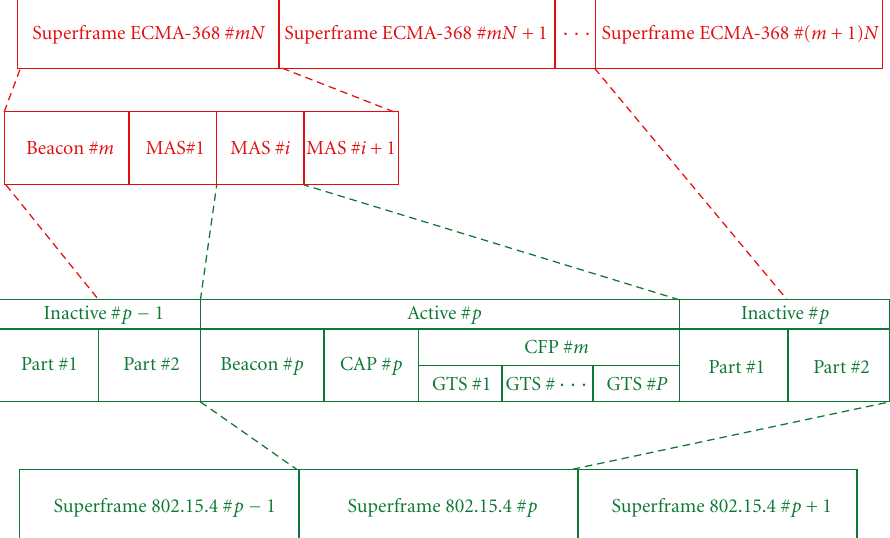
respectively, see Table 3. It is worth noting that the duty cycle of the HDR network is complementary to the duty cycle of the LDR